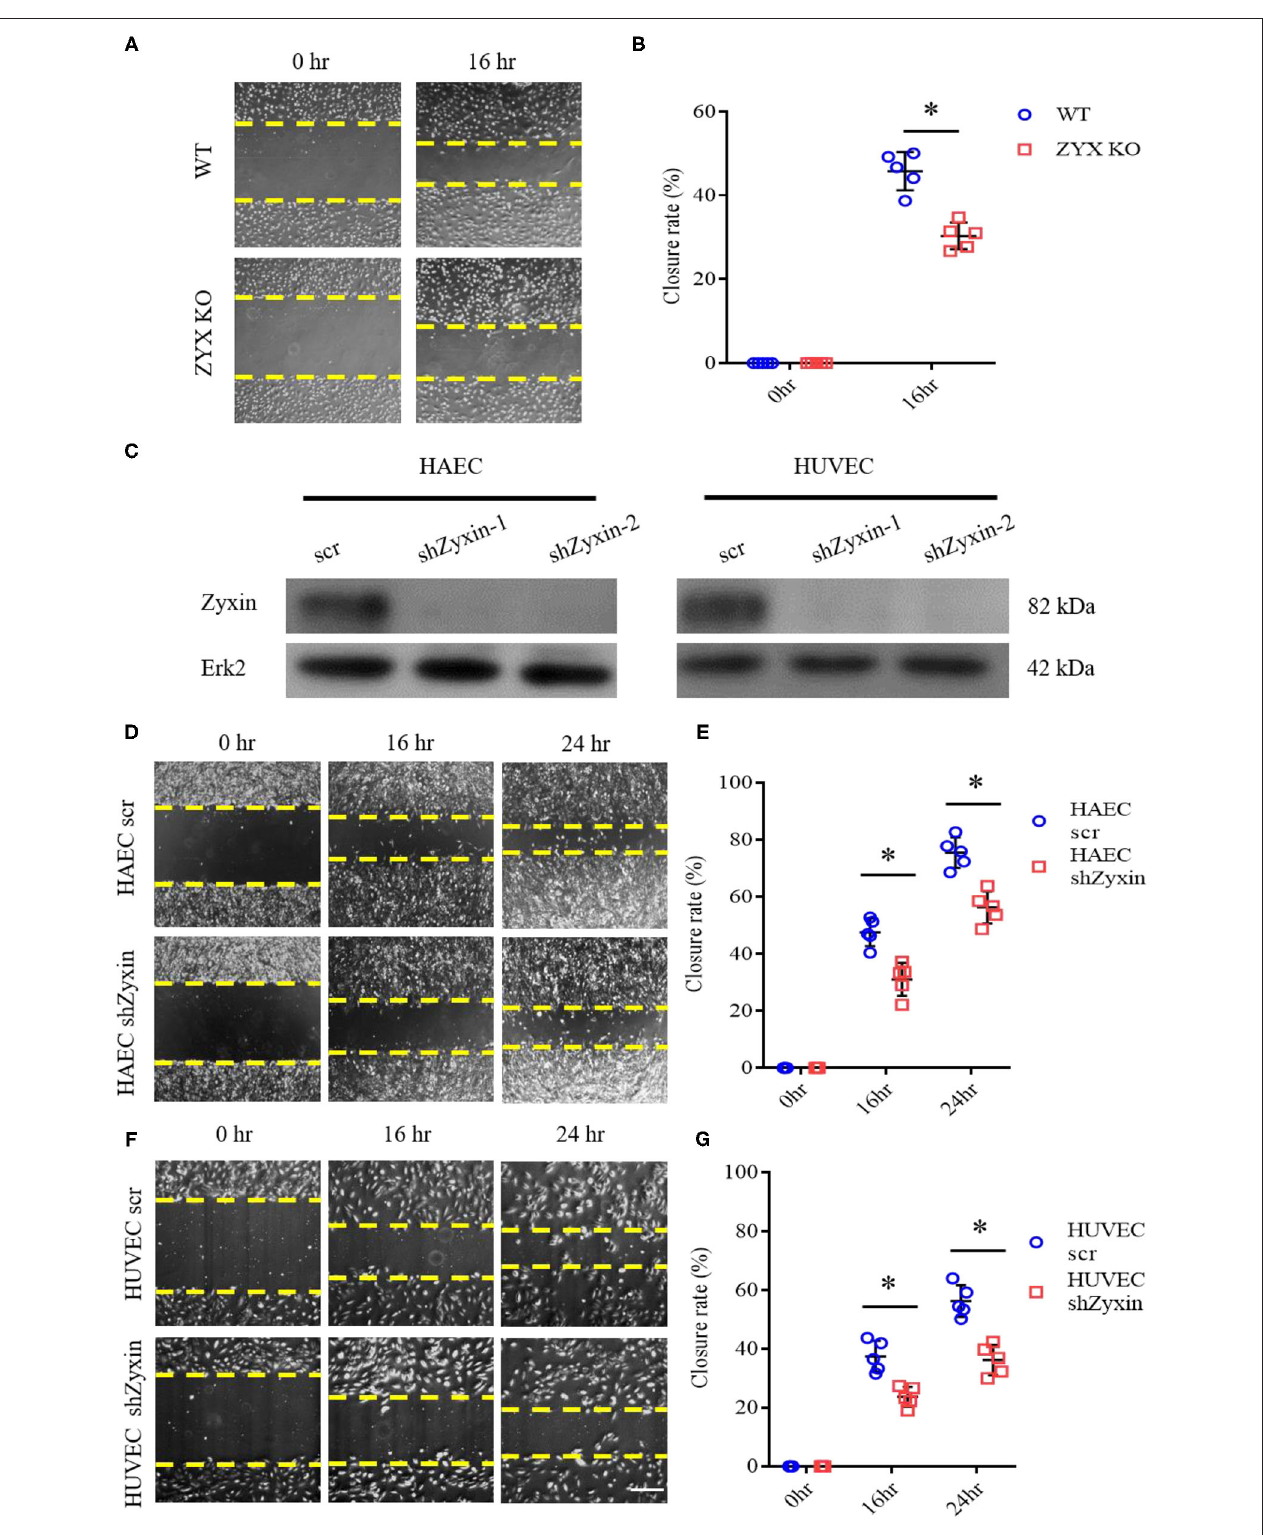
FIGURE 5 | Zyxin deficiency reduces vascular endothelial cell migration. (A) Migration of primary ECs isolated from the WT and ZYX KO mice was assessed by a scratching wound-healing assay. Representative images were taken 0 and 16h post scratching. (B) Quantification of mean closure rate 16h after scratching. (C) Western blots of protein level of zyxin and Erk2 in human amniotic epithelial cells (HAECs) and human umbilical vein endothelial cells (HUVECs) expressing scrambled